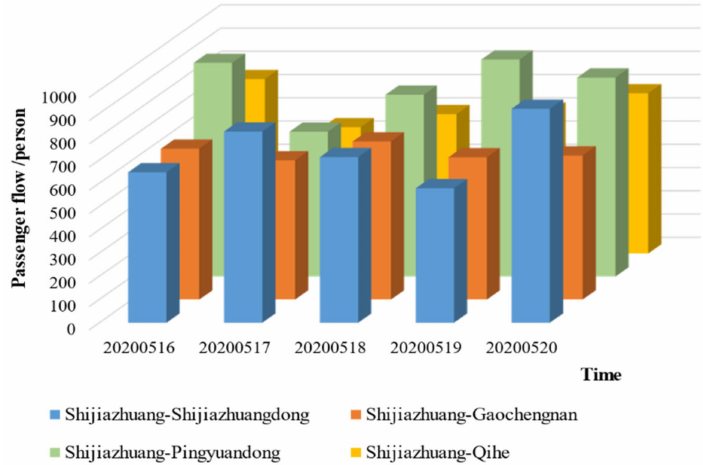
Figure 2. The fluctuation of the same OD passenger flow on each operation